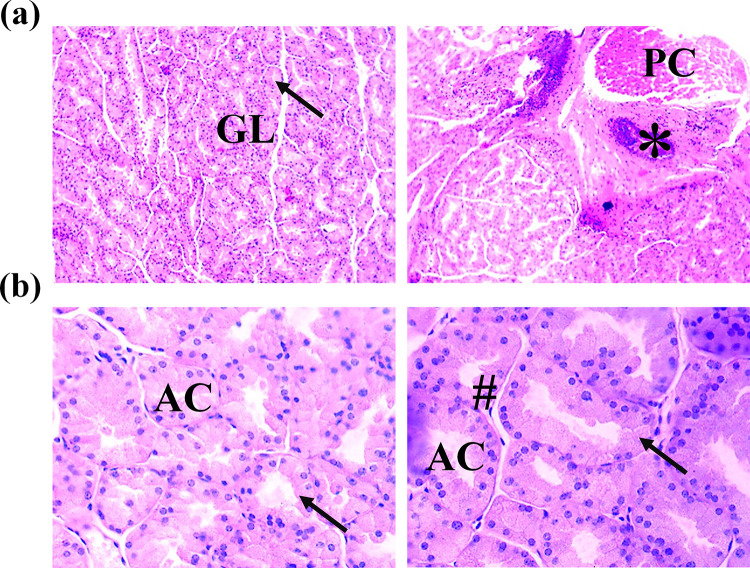
histological structure of HG by HE staining in hamsters.(a) Plasma cells and secretory ducts in HG are shown under low-power magnification. Scale bar = 100 μm. (b) Plasma cells and secretory ducts in HG are shown under high-power magnification. Scale bar = 20 μm. Arrow, acinar cell; asterisk, secretory duct; PC, plasma cells; GL, gland leaflet; AC, acinar cavity; #, epithelial cell.